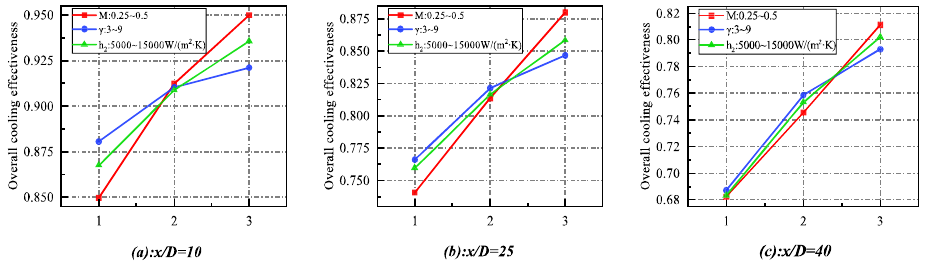
Figure 13. Sensitivity analysis result at three x/D.